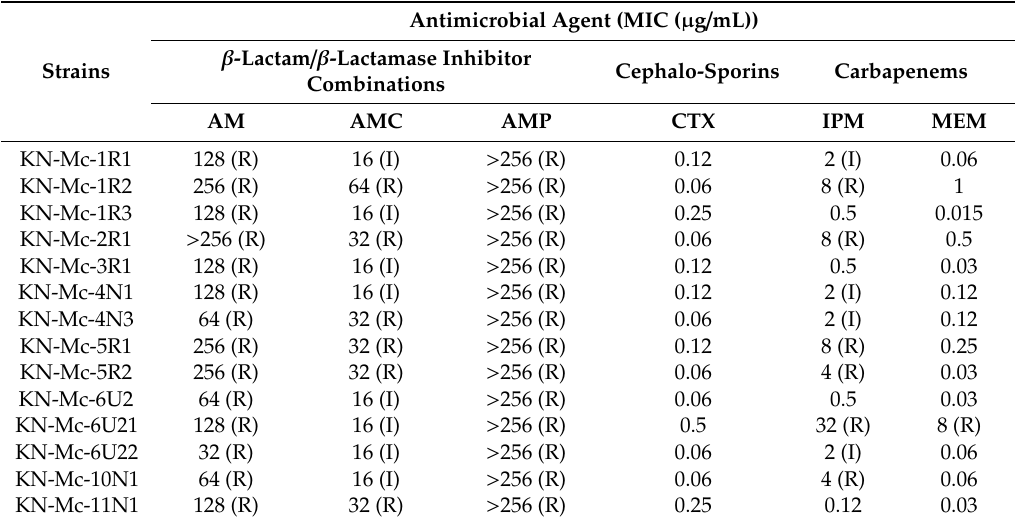
Table 4. MICs of six selected antimicrobial agents for the 14 Aeromonas isolates. Antimicrobial Agent (MIC ( µ g / mL)) β -Lactam / β -Lactamase Inhibitor Strains Combinations